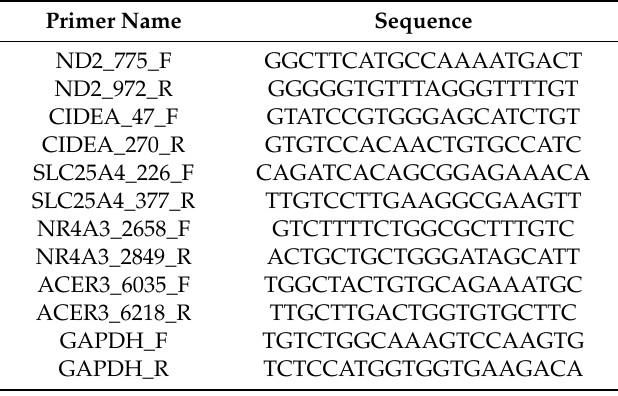
Table 1. Duck primers for real-time